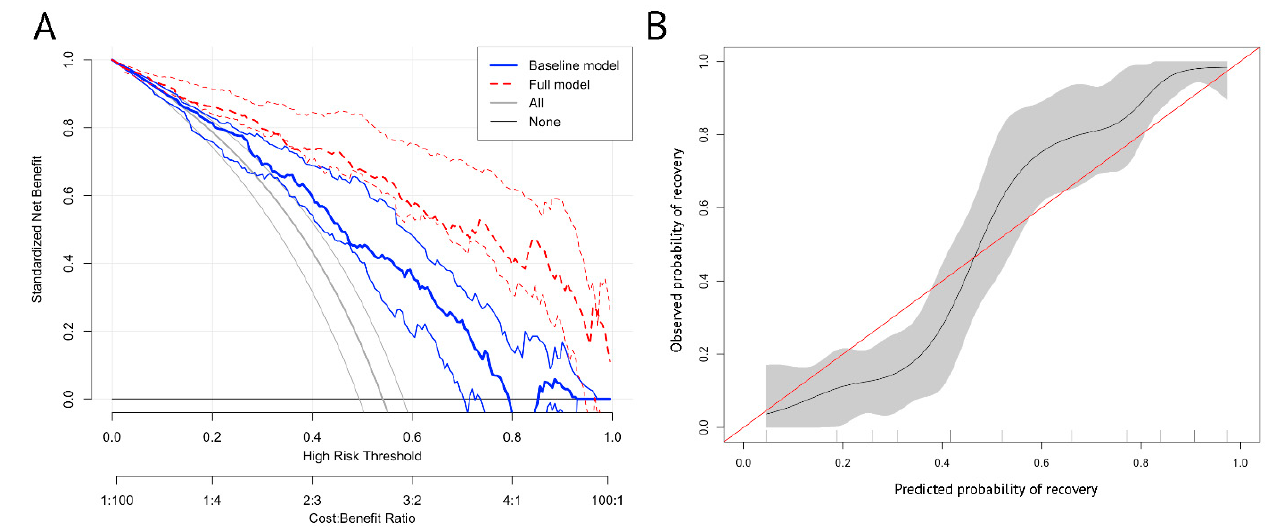
Figure 4. Decision support curve and calibration plot. ( A ) The curve presented that the net benefit of our full model was higher than the non-model or model only using the visual field as the predictor (baseline model). Standardized net benefit is a measure of utility that calculates a weighted sum of true positives and false positives, weighted according to the threshold. ( B ) The model showed good calibration with an intercept close to 0 and a slope close to 1. The width of the grey area represents the number of patients at each level of “predicted probability of recovery”. A model explanation using the SHAP score demonstrated that visual field, GCL, tumor height, total thyroxine, and diagnosis were the most important features in predicting visual outcome. We illustrate two cases in Figure 5, one recovered and the other